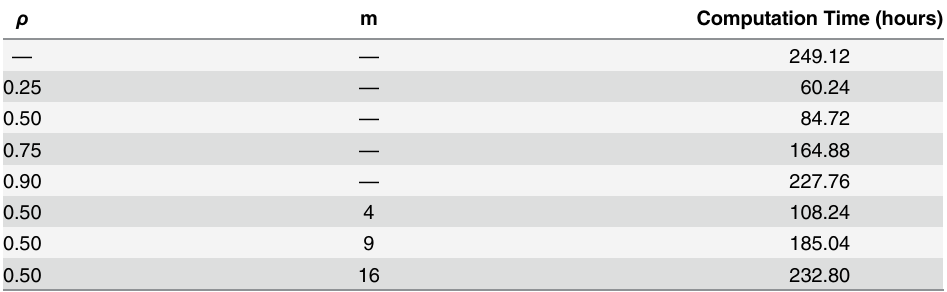
Table 2. Computation times for the